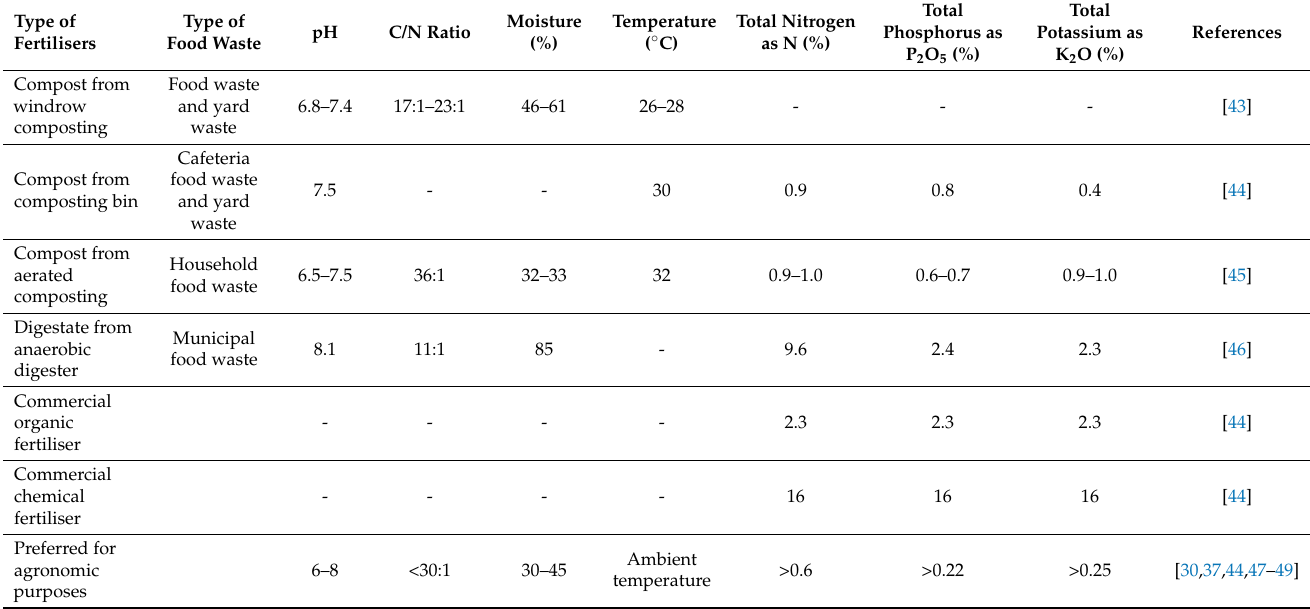
Table 2. The physiochemical characteristics of different types of